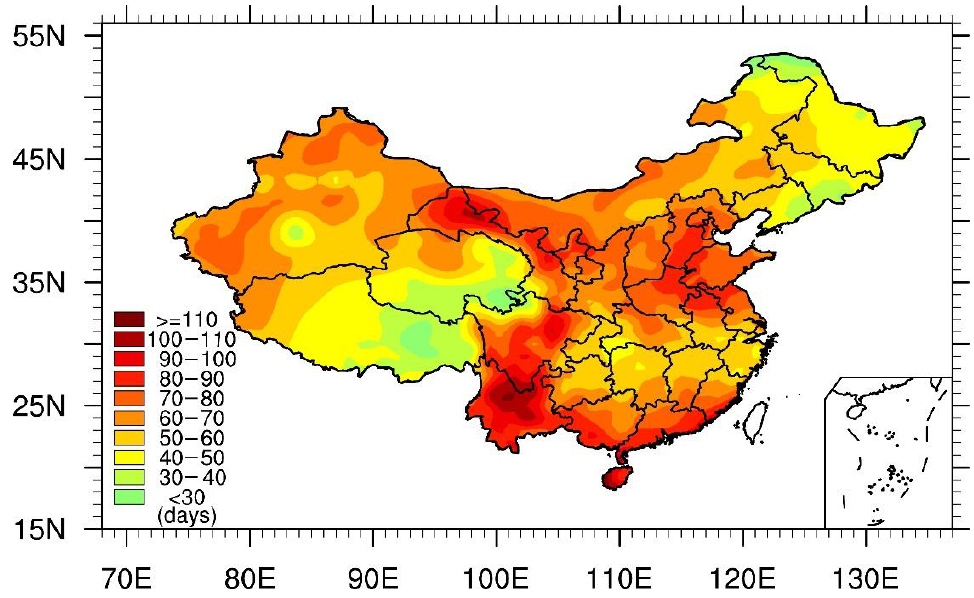
Figure 3. Spatial distribution of annual average drought days in China (unit: